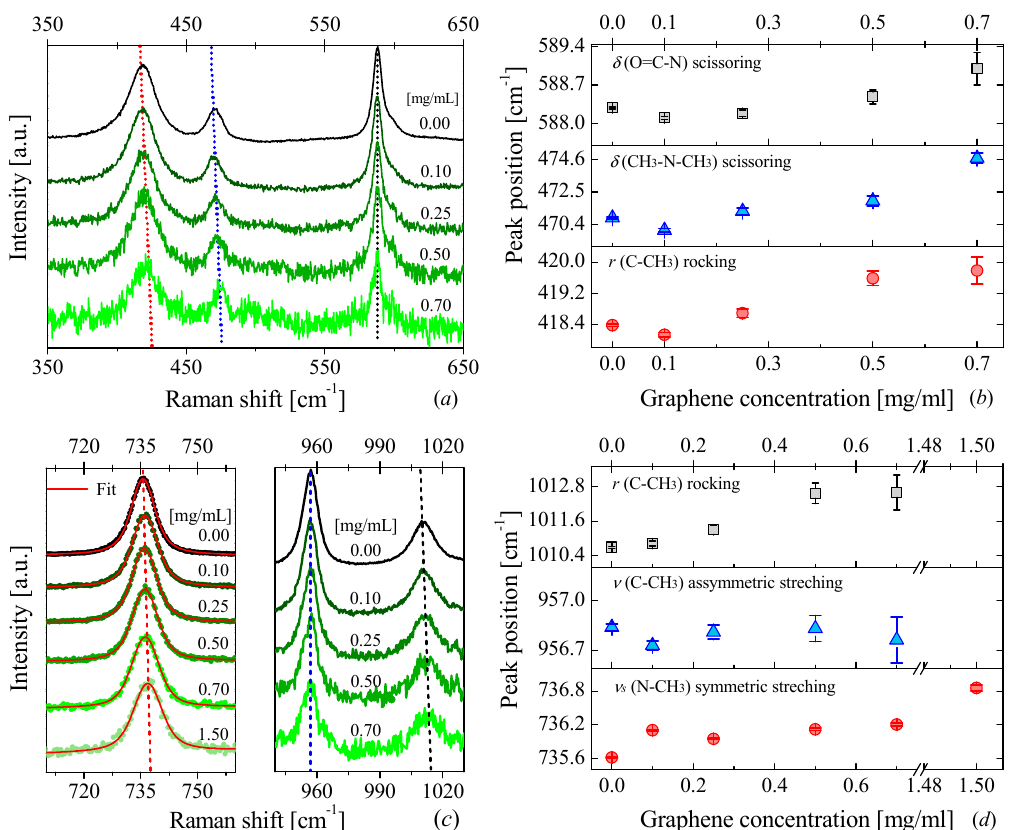
Figure1. RamanscatteringofDMAc-basedNFsandpeakpositionsofseveralRamanbands: ( a , c )Raman Figure 1. Raman scattering of DMAc-based NFs and peak positions of several Raman bands: ( a ) and spectra of DMAc-based NFs for di ff erent graphene concentrations, ( b , d ) peak positions of six Raman ( c ) Raman spectra of DMAc-based NFs for different graphene concentrations, ( b ) and ( d ) peak bands shown in ( a , c ) as a function of graphene positions of six Raman bands shown in ( a ) and ( c ) as a function of graphene concentration.